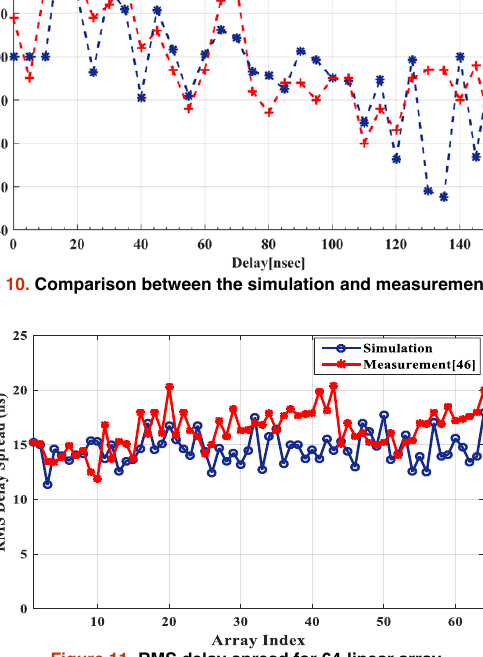
Figure 11. RMS delay spread for 64-linear